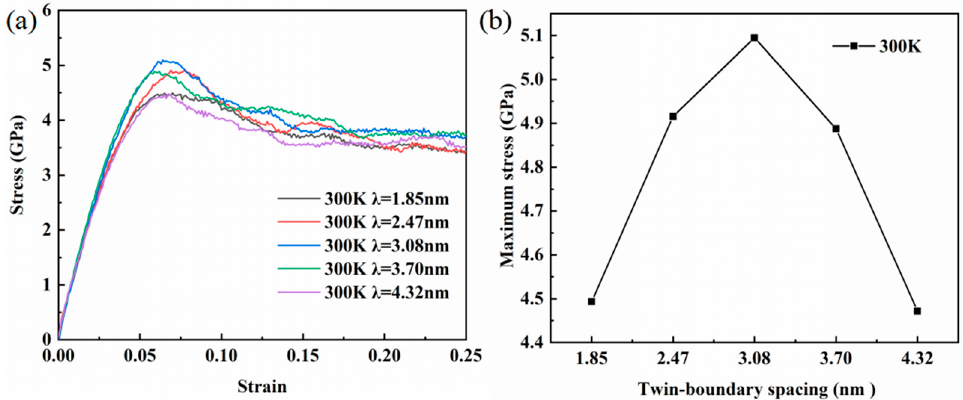
Figure 10. ( a ) Stress-strain curves of samples with different λ (from 1.85 to 4.32 nm) at 300 K, ( b ) maximum stress at different λ at 300 K.